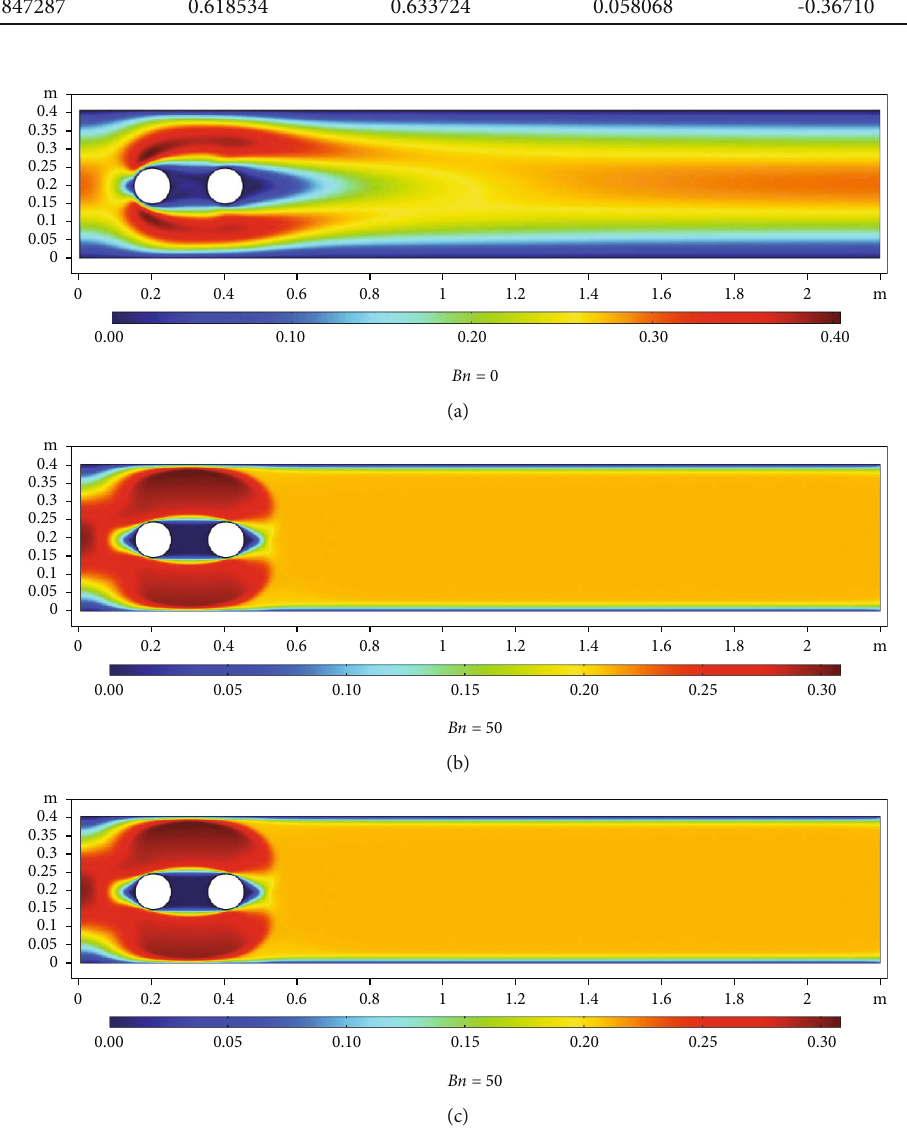
= 0 : 1 and Re = 20 . (a) Bn = 0 : (b) Bn = 10 . (c) Bn = 50 p